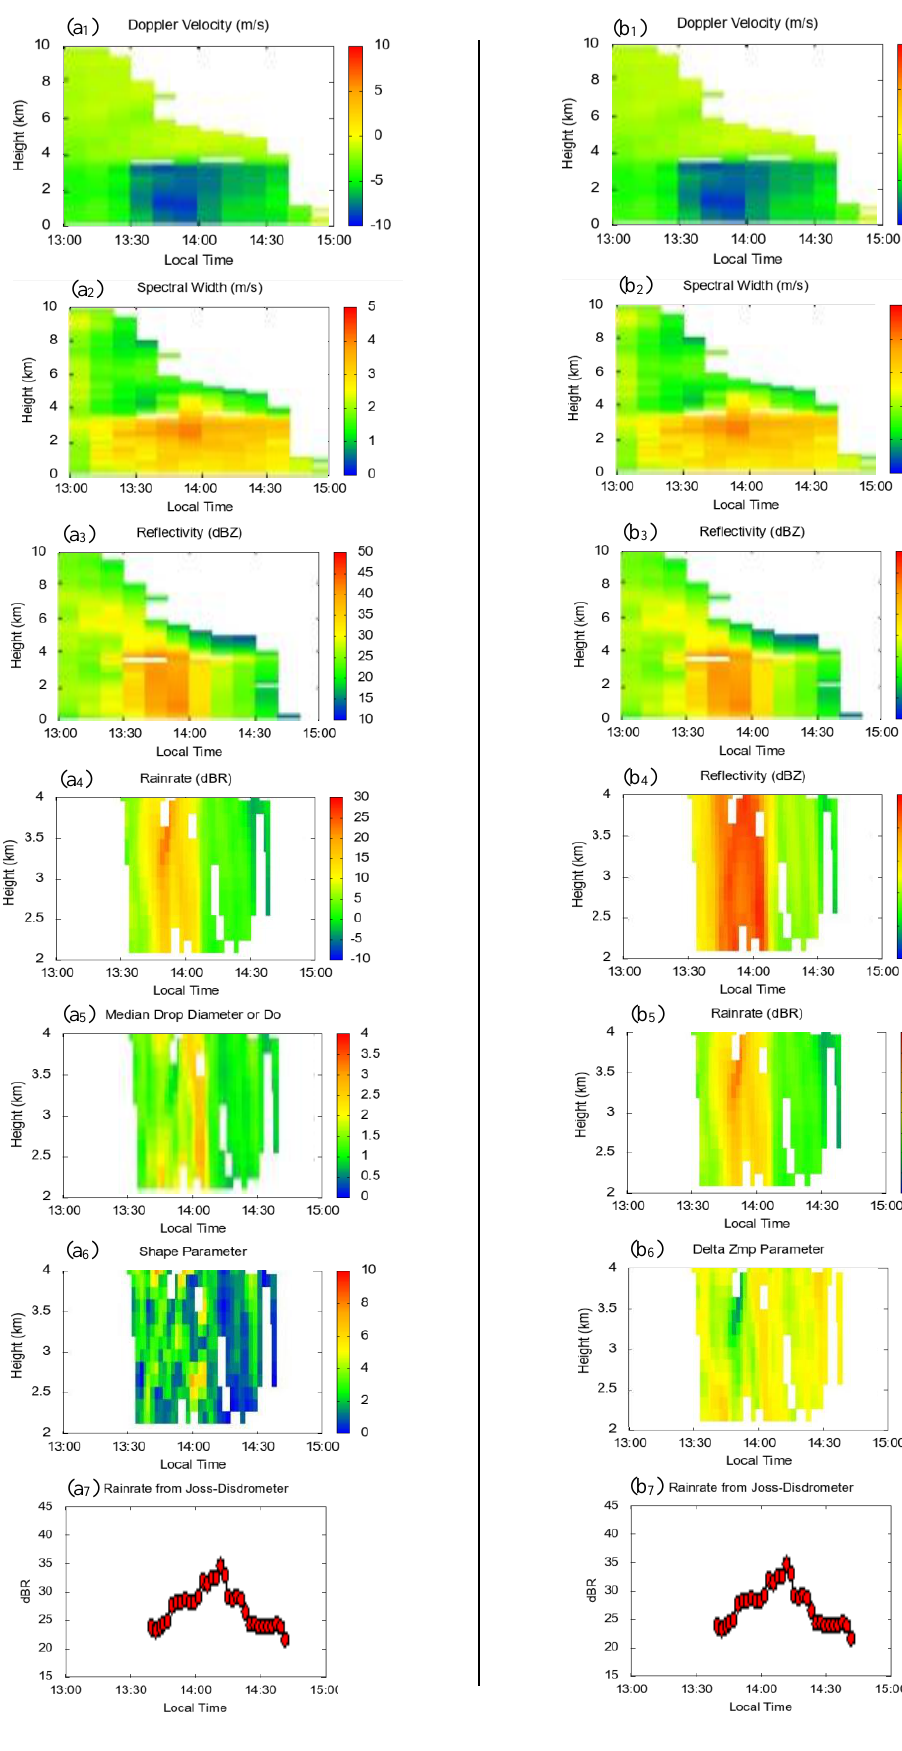
Figure 5. The left side (a) shows parameters for microphysical analysis and the right side (b) shows parameter for remote sensing application analysis on April 23,